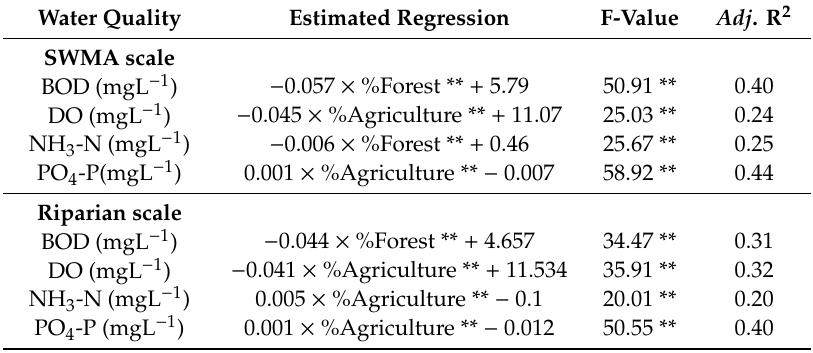
Table 3. The estimated ordinary least squares (OLS)-based regression models at SWMA and riparian scales. Water Quality Estimated